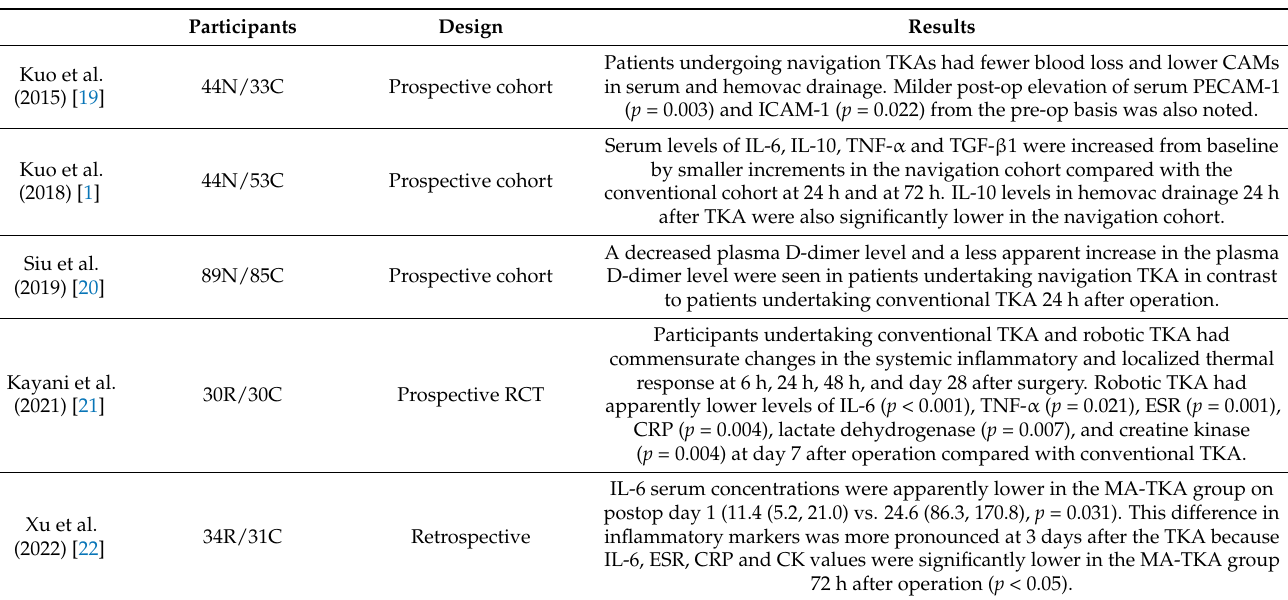
Table 6. The comparison of systemic biological factors between the conventional and the technique avoiding intramedullary